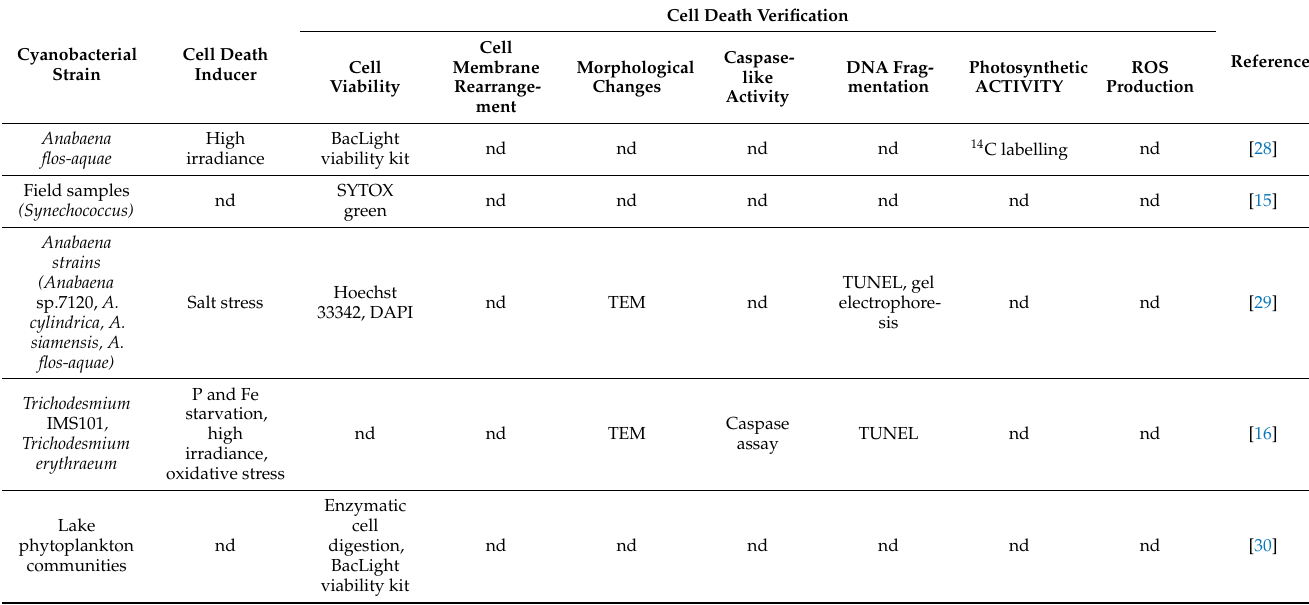
Table 1. Characterization of RCD in